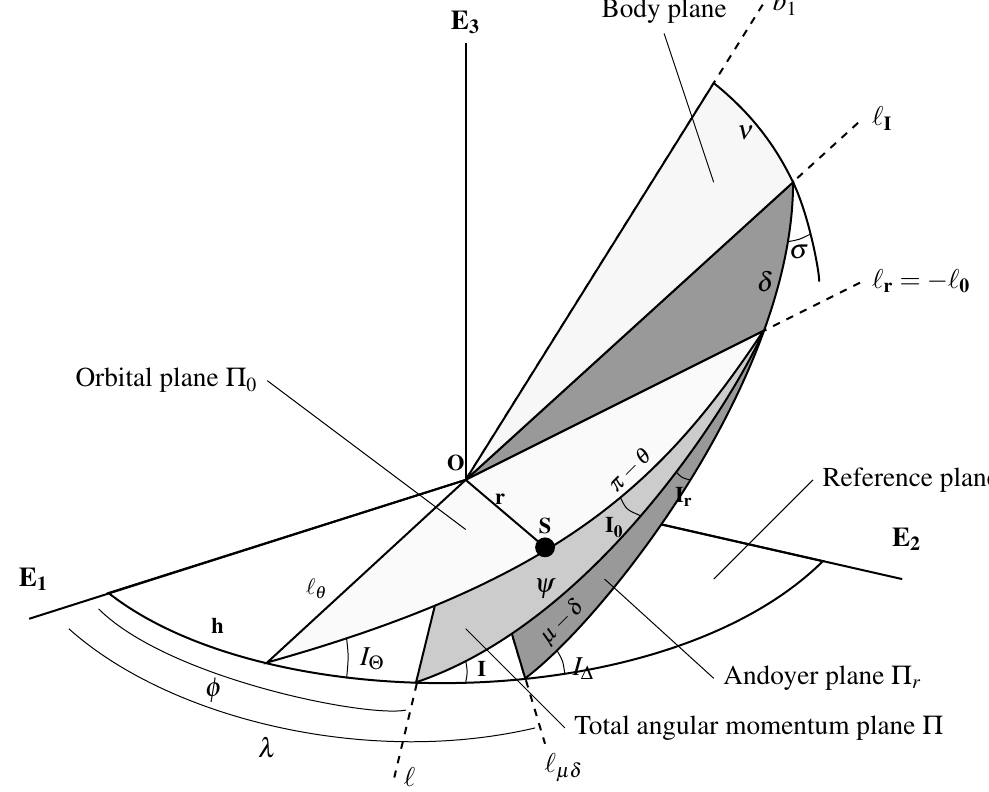
Fig. 1 Geometry of the variables ( r , φ , ψ , θ , δ , ν , R , Φ , Ψ , Θ , ∆ , N ) . The variable r and the angles are explicitly given in the figure, while the associated momenta are included implicitly through the inclinations of the planes. The conjugate variable R remains unrepresented because of its pure dynamical